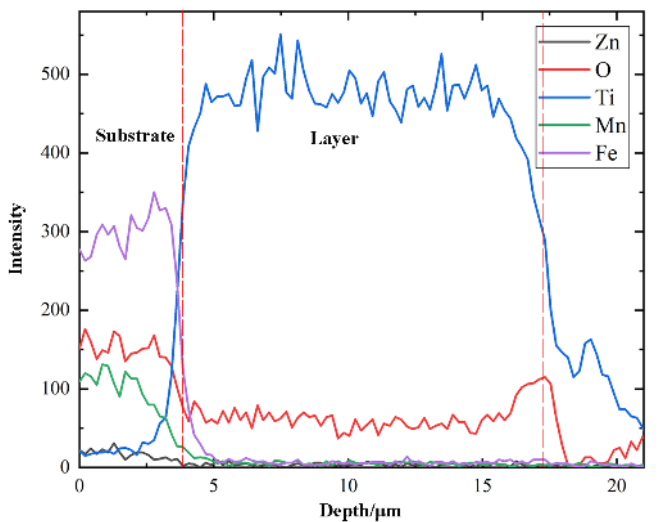
Figure 6. EDS line scanning results of a cross-section of MnZn ferrite immersed in molten salt for 2 min.